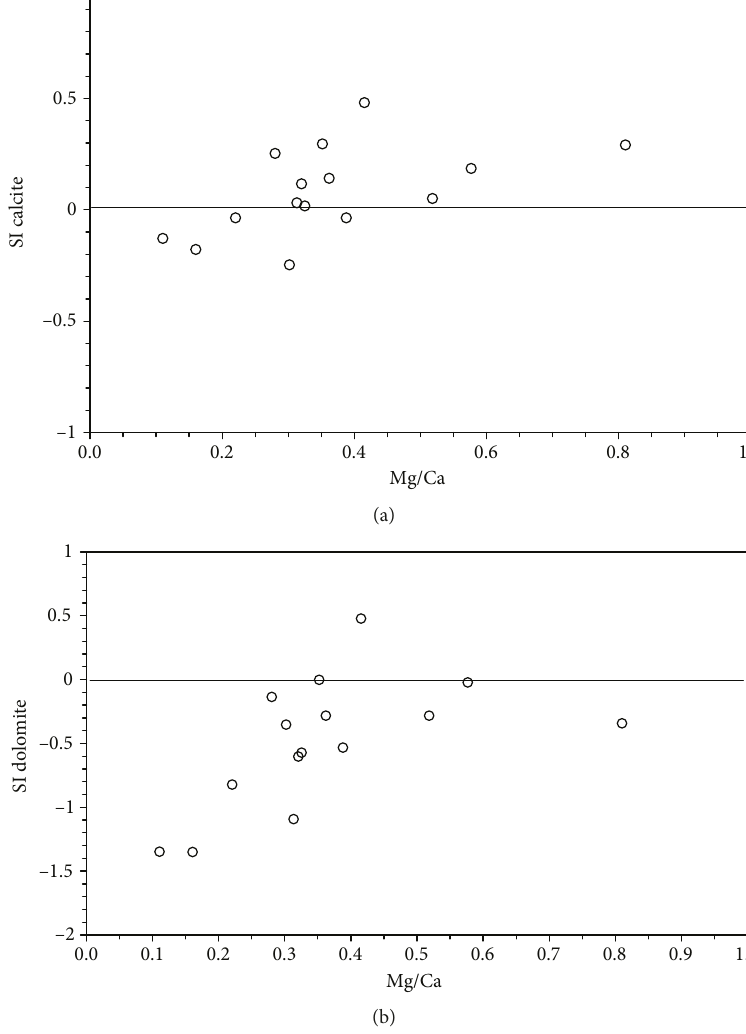
Figure 6: (a) Saturation index (S.I.) of calcite versus Mg/Ca ratio. (b) Saturation index (S.I.) of dolomite versus Mg/Ca